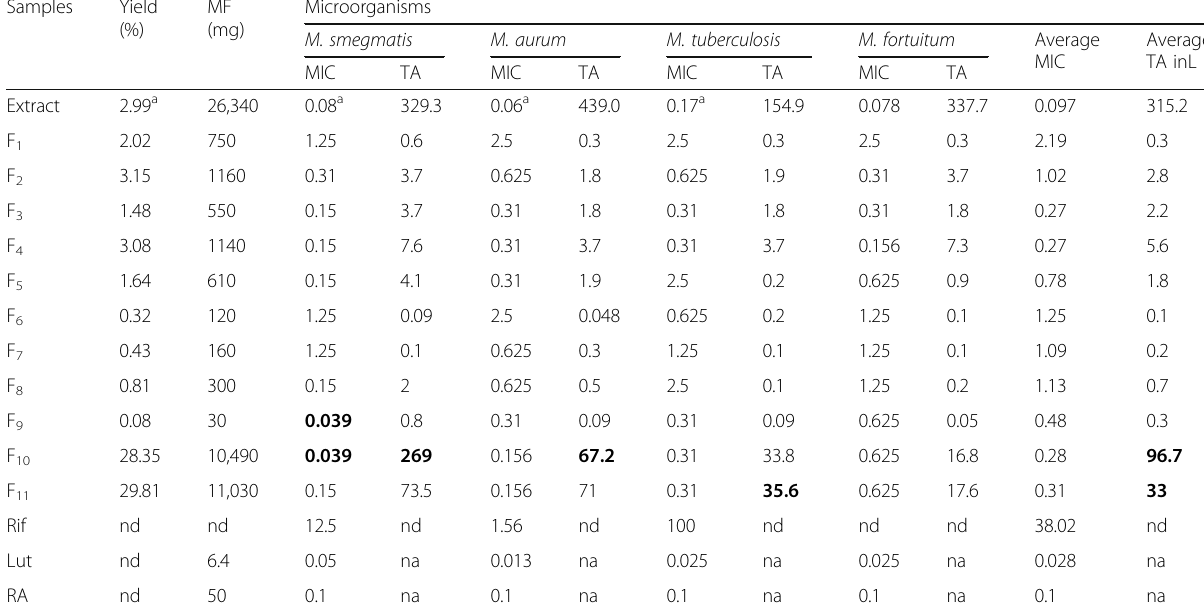
Table 2 Minimal inhibitory concentration (MIC in mg/mL) and total activity (TA) in L of extract, fractions and isolated compounds of Oxyanthus speciosus . (TA in L is calculated by dividing mass of fraction in mg (MF) by MIC in mg/mL and dividing the answer by